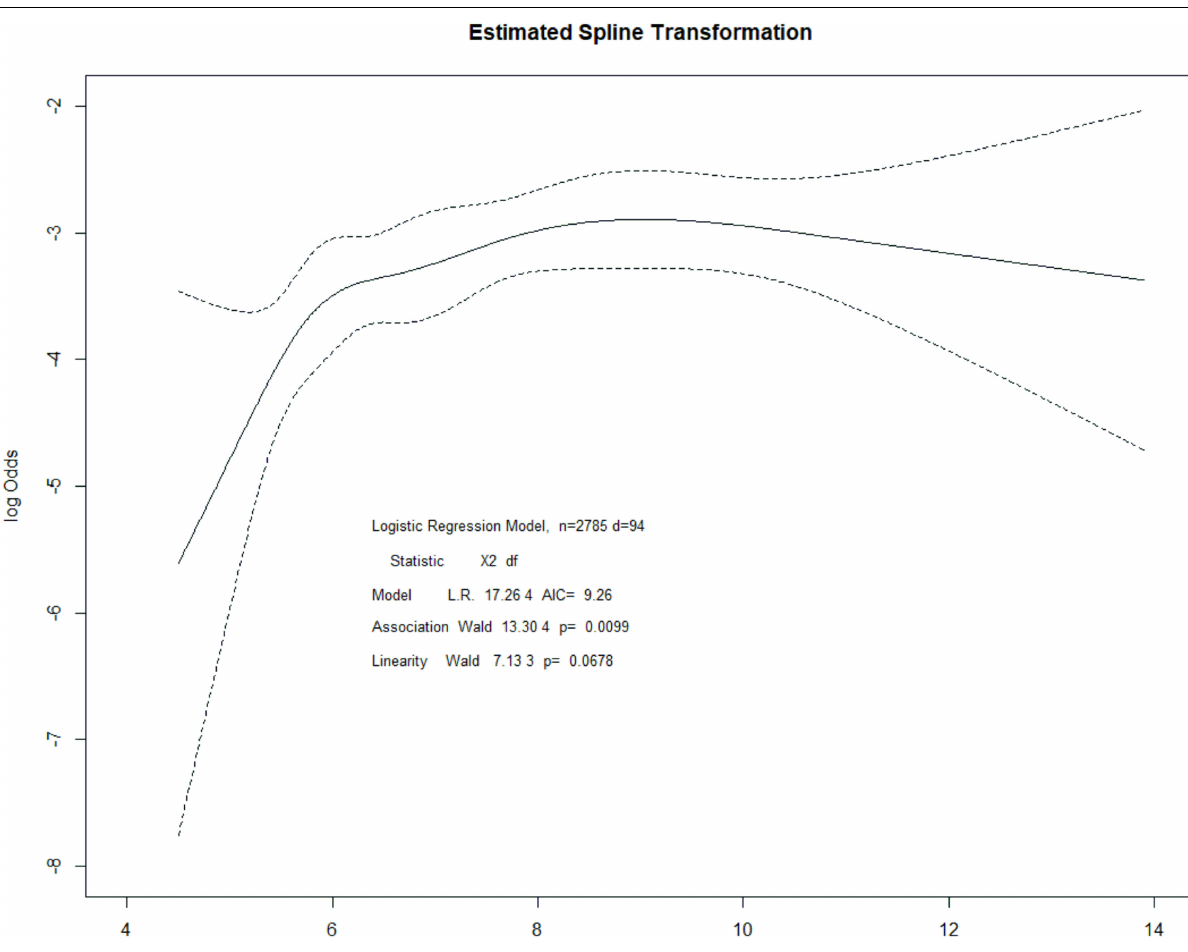
FIGURE 2 | Restricted cubic spline regression for the association between HbA1c and post-operative